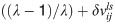
Spatial pattern at given times with different initial value ((λ-1)/λ)+δvijls.Snapshots of the spatial grid at given times t for various l, s when the initial value is selected as ((λ-1)/λ)+δvijls with δ = 0.01, λ = 2.9 and ε = 0.34. (A) l = 2, s = 2, t = 50000. (B) l = 5, s = 50, t = 50000. (C) l = 50, s = 50, t = 5000. (D) l = 5, s = 95, t = 50000.